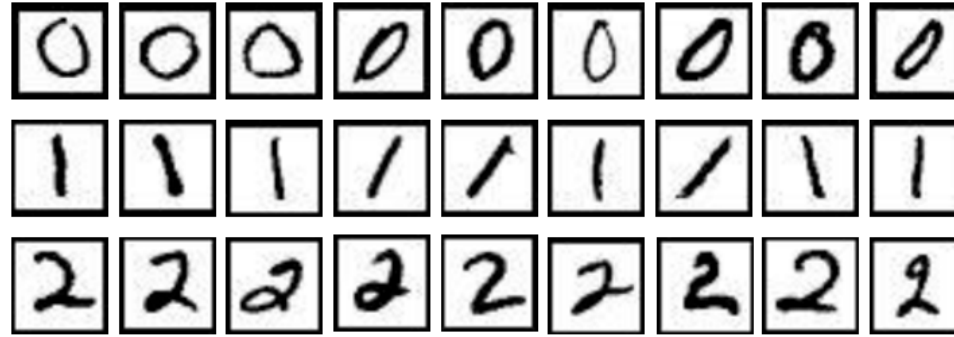
Figure 3. Some samples of the MNIST database.